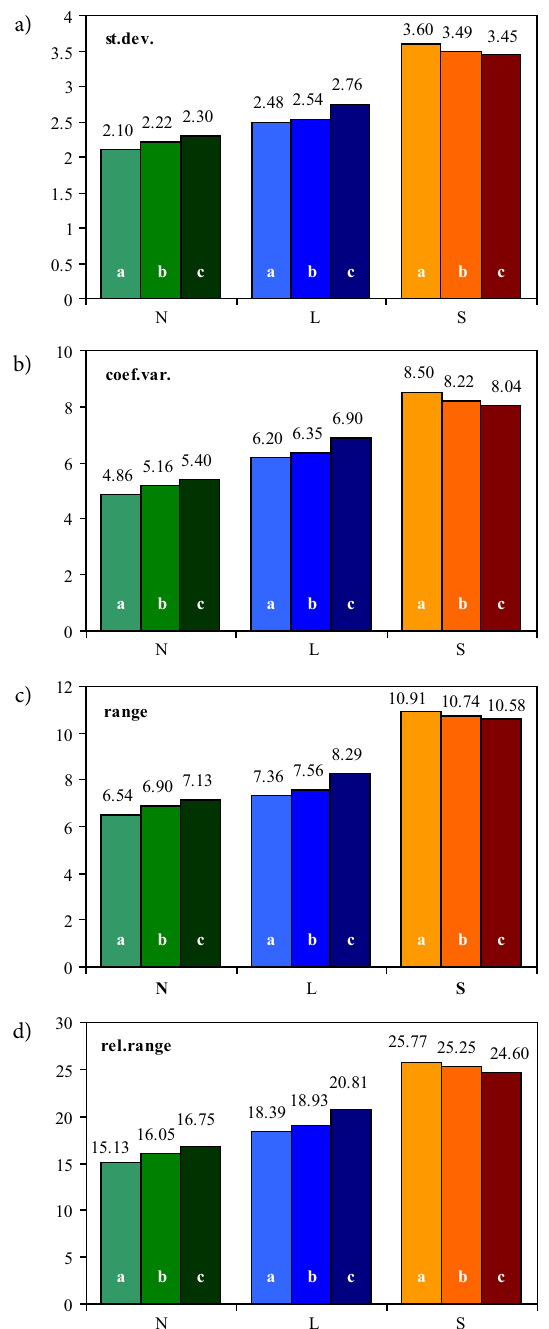
Fig. 4. a – standard deviation ( s ) of individual rebound index R readings corresponding to the testing locations; b – coefficient ) of individual rebound index readings of variation ( V R ) of corresponding to the testing locations; c – range ( r R individual rebound index readings corresponding to the testing ) of individual rebound index locations; d – relative range ( ρ R readings corresponding to the testing locations